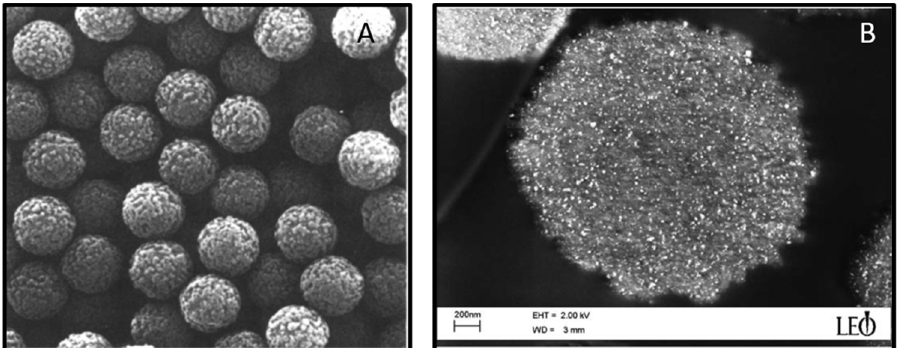
Figure 9. ( A ) Polystyrene beads of average diameter 2.8 microns containing 12 w/w % iron in their pores. ( B ) SEM of a M-280 bead from Dynabeads TM . The nanoparticles in the bead are visualized as bright points and were determined to be ~8 nm in diameter. ( B ) Reproduced with permission from Ugelstad et al., Progress in Polymer Science; published by Elsevier, 1992. Reproduced with permission from Fonnumm et al., Journal of Magnetism and Magnetic Materials; published by Elsevier, 2005.